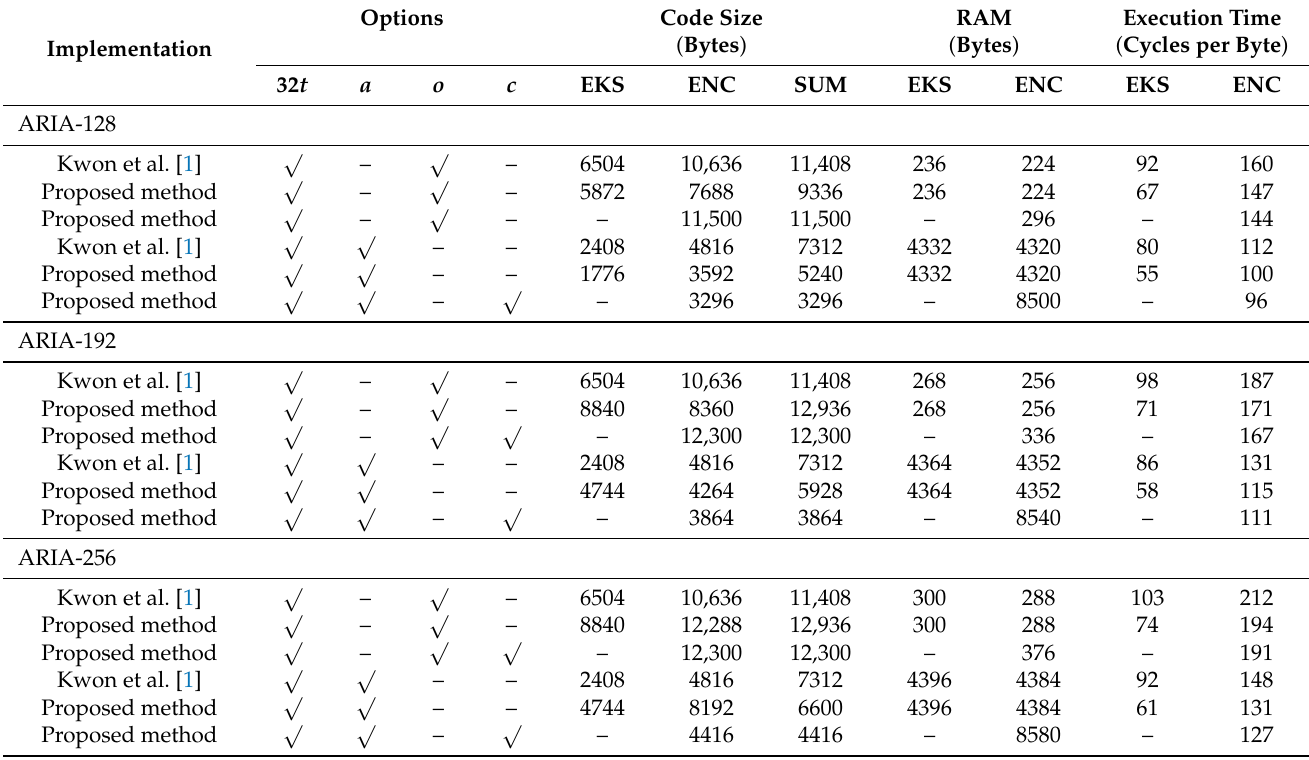
Table 6. Performance evaluation of ARIA on ARM-M3 in terms of code size (bytes), RAM (bytes), and execution time (clock cycles per byte), where 32 t a , o , and c represent 8 × 32 pre-computation-based implementation, pre-computation stored in RAM, pre-computation stored in ROM, and counter mode of operation, respectively. EKS, ENC, and SUM represent encryption key scheduling, encryption, decryption, and summation,